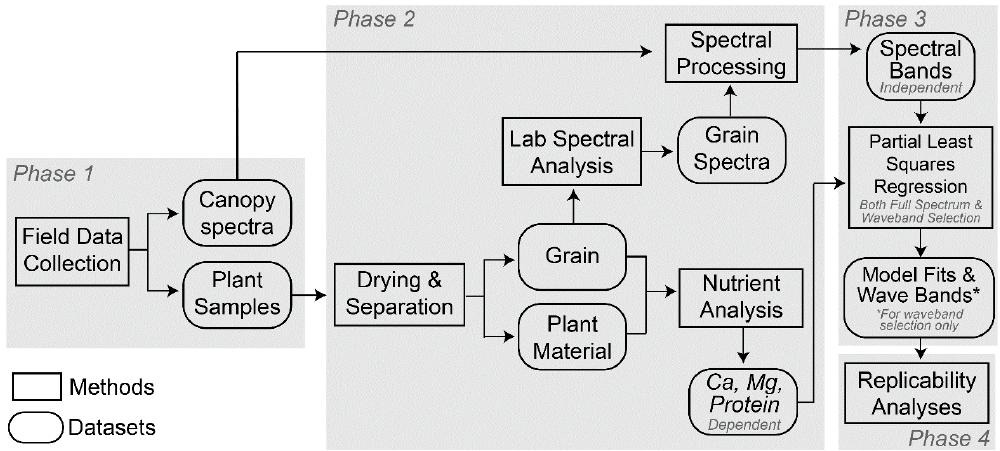
Figure 2. Methods flowchart detailing data collection and processing methods .